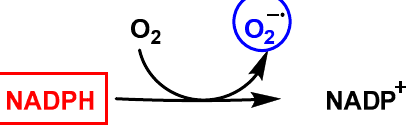
Figure 12. Reduction of O 2 to O 2•– by NADPH. NOX are mainly located in the plasma membrane [31,32]. NOX2 proteins are constitutively present and, upon inflammatory stimuli, activated NOX2 converts molecular oxygen to superoxide using electrons from NADPH and releases superoxide. NOX2 is predominantly expressed in phagocytes and produces a relatively large amount of superoxide in order to kill bacteria within phagosomes in an inflamed area [33,34], Figure 13.